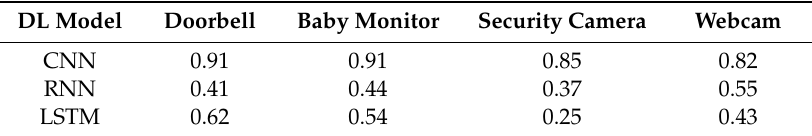
Table 14. Average F1-score of the DL